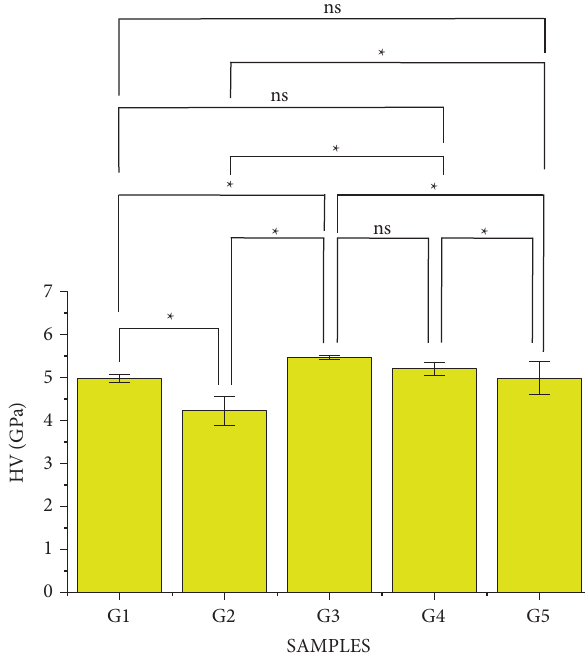
Figure 6: Bar graph of Vickers hardness of ceramics. Analysis of variance with Tukey’s multiple comparison test was used to compare the hardness of ceramics in this study. ∗ represents the significant difference between the groups and (ns) represents the nonsignificant